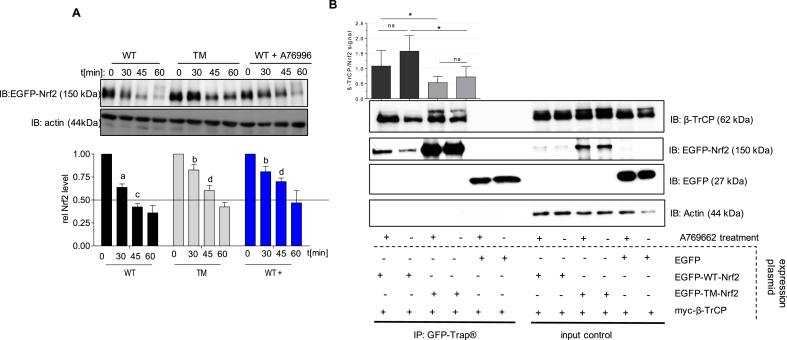
Mutation of the AMPK-dependent phosphosites to alanine stabilizes Nrf2 in Keap1−/− cells and impedes interaction with β-TrCP. (A) Keap1−/− MEF were transfected with EGFP-tagged WT- or TM-Nrf2 expression plasmids, pretreated with A76996 (50 μM, 1h) as indicated and then exposed to cycloheximid (30 μM) for different periods of time. Cell lysates were subjected to immunoblot analysis for EGFP or actin. Representative blots and compiled densitometric evaluations (EGFP-WT/TM-Nrf2/actin, related to signal at t = 0) are depicted (n = 3, mean +SD, unpaired Student's t-test, two tailed, α = 0.05, different superscript letters indicate differences with p < 0.05). (B) HEK cells were transfected with an expression plasmid for myc-tagged β-TrCP together with constructs encoding EGFP-WT-Nrf2, the triple mutated version EGFP-TM-Nrf2, or EGFP as indicated. Cells were treated with vehicle (DMSO) or A769662 (50 μM) 1 h prior to addition of MG132 (20 μM) for further 3 h to stabilize Nrf2, which was pulled down using GFP-Trap®. (Co) precipitated proteins as well as input controls were immunoblotted for myc (=β-TrCP) or GFP (=EGFP-WT-/EGFP-TM-Nrf2 or EGFP) as indicated. Representative blot pictures and densitometric evaluations (relative myc (β-TrCP)/GFP (Nrf2) signal) are depicted. (n = 6, mean +SD; *P < 0.05, Welch's t-test, two tailed, α = 0.05).